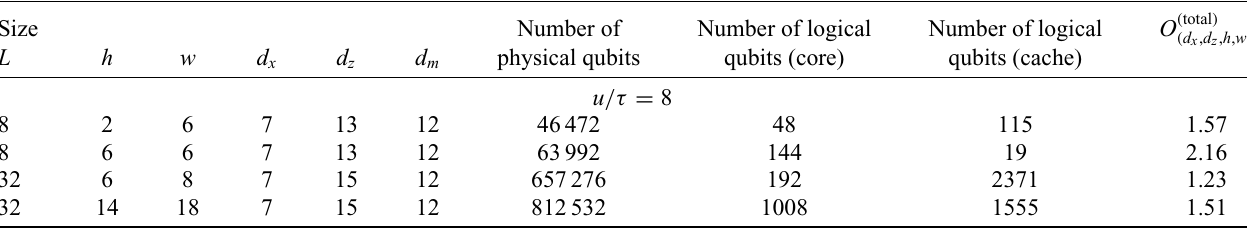
TABLE I. For a Hubbard-model simulation with lattice size L and unit cells of height h and width w in the core, we provide the minimum values of d x , d z , and d m such that Eqs. (C7)–(C9) are satisfied with δ ∼ 1%. For the given parameters, we also provide the total number of physical qubits using Eq. (C6) and the number of logical qubits in the core and in the cache. The last column includes the multiplicative factor [defined in Eq. (C3)] that is added to the physical qubit overhead, which takes routing costs into account. The values for N TOF and N T used in computing μ are obtained from Ref. [75]. All resource costs exclude contributions from the magic state